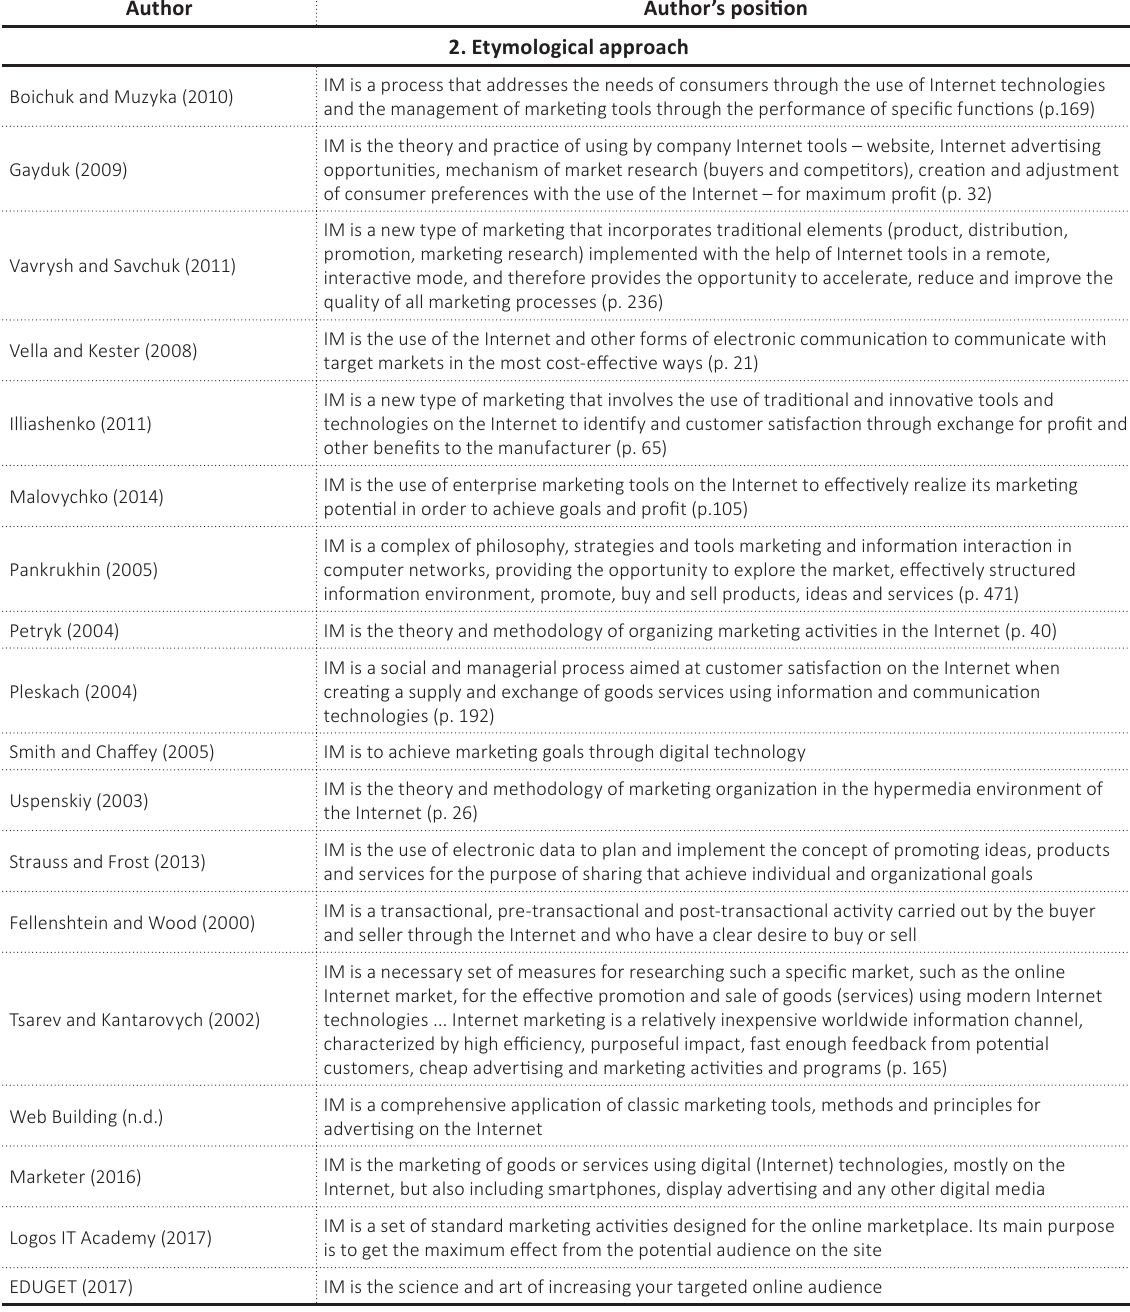
Table 2 (cont.). The selected conceptual approaches of scientists and marketers to defining “Internet marketing”